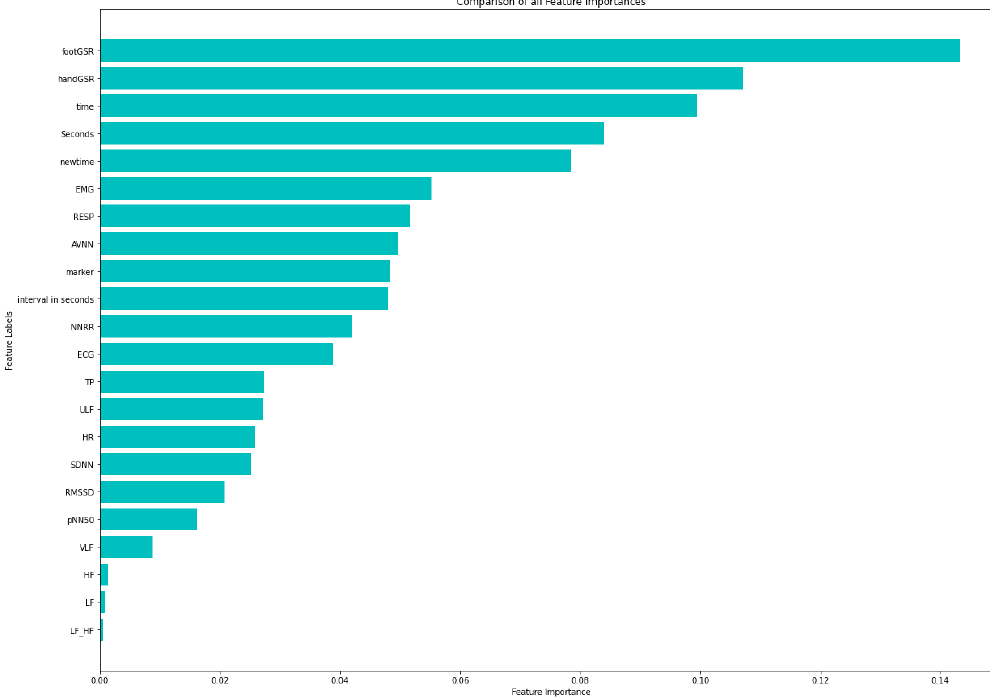
Figure 4. Feature Importance of features from original-dataset using Extra Trees Classifier.